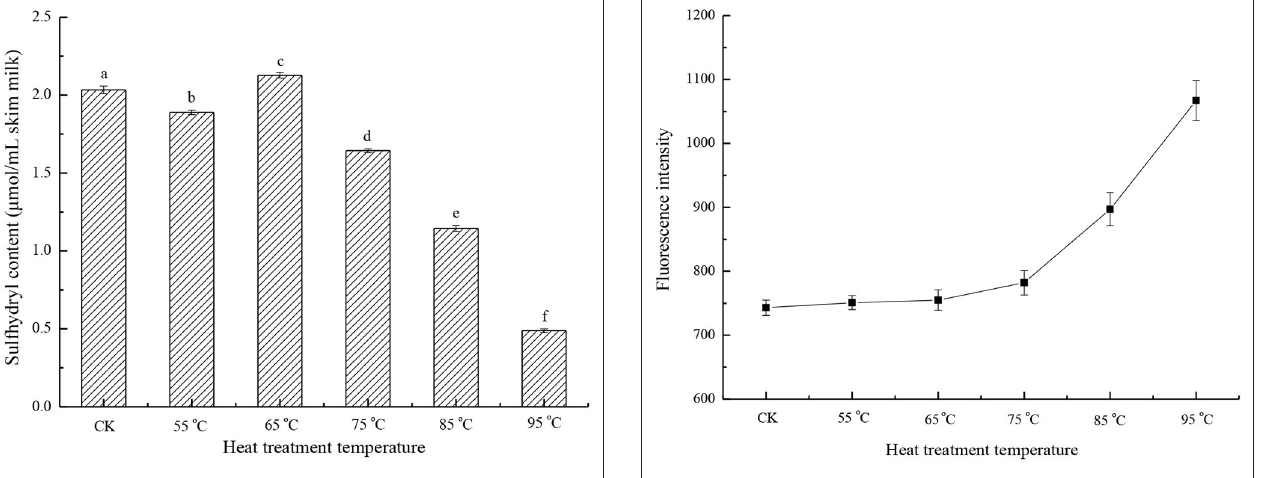
FIGURE 2 | Surface hydrophobicity of different heat-treated skim milk. CK, skim milk without heat